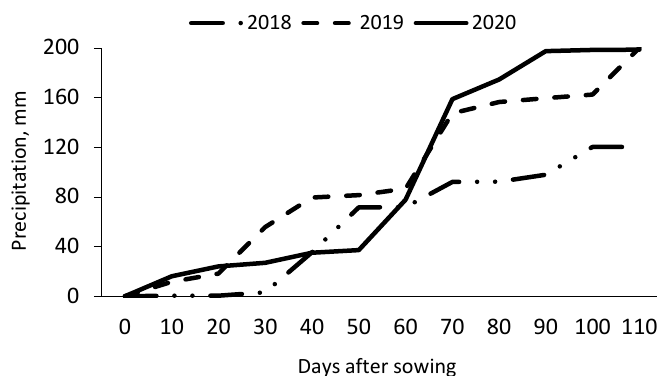
Fig. 1. Cumulative rainfall (mm) at 10-days intervals after sowing during 2018–2020. Data Source: Finnish Meteorological Institute, Jokioinen Observatory